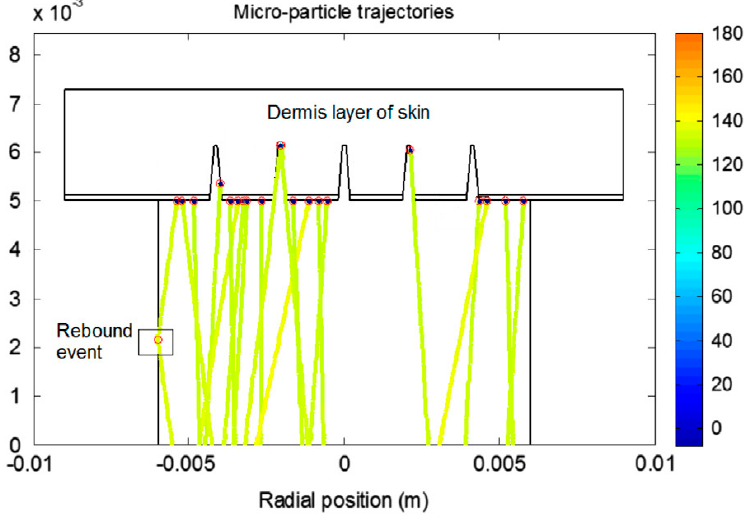
Figure 9. The histological image of sliced skin is processed by a MATLAB-based image processing tool. ( A ) the original image of skin histology; ( B ) the outline of the skin captured by the image processing tool and ( C ) simulated diffusion profile of insulin in MN-pierced skin (adopted from [108]).